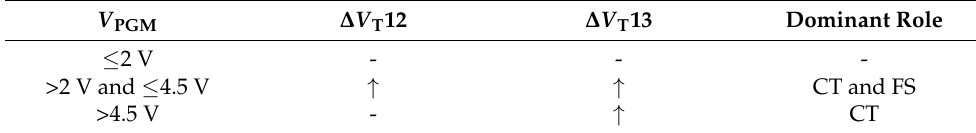
Table 1. Variation of ∆ V T at various V PGM by the single-pulse I D - V G method. V PGM ∆ V T 12 ∆ V T